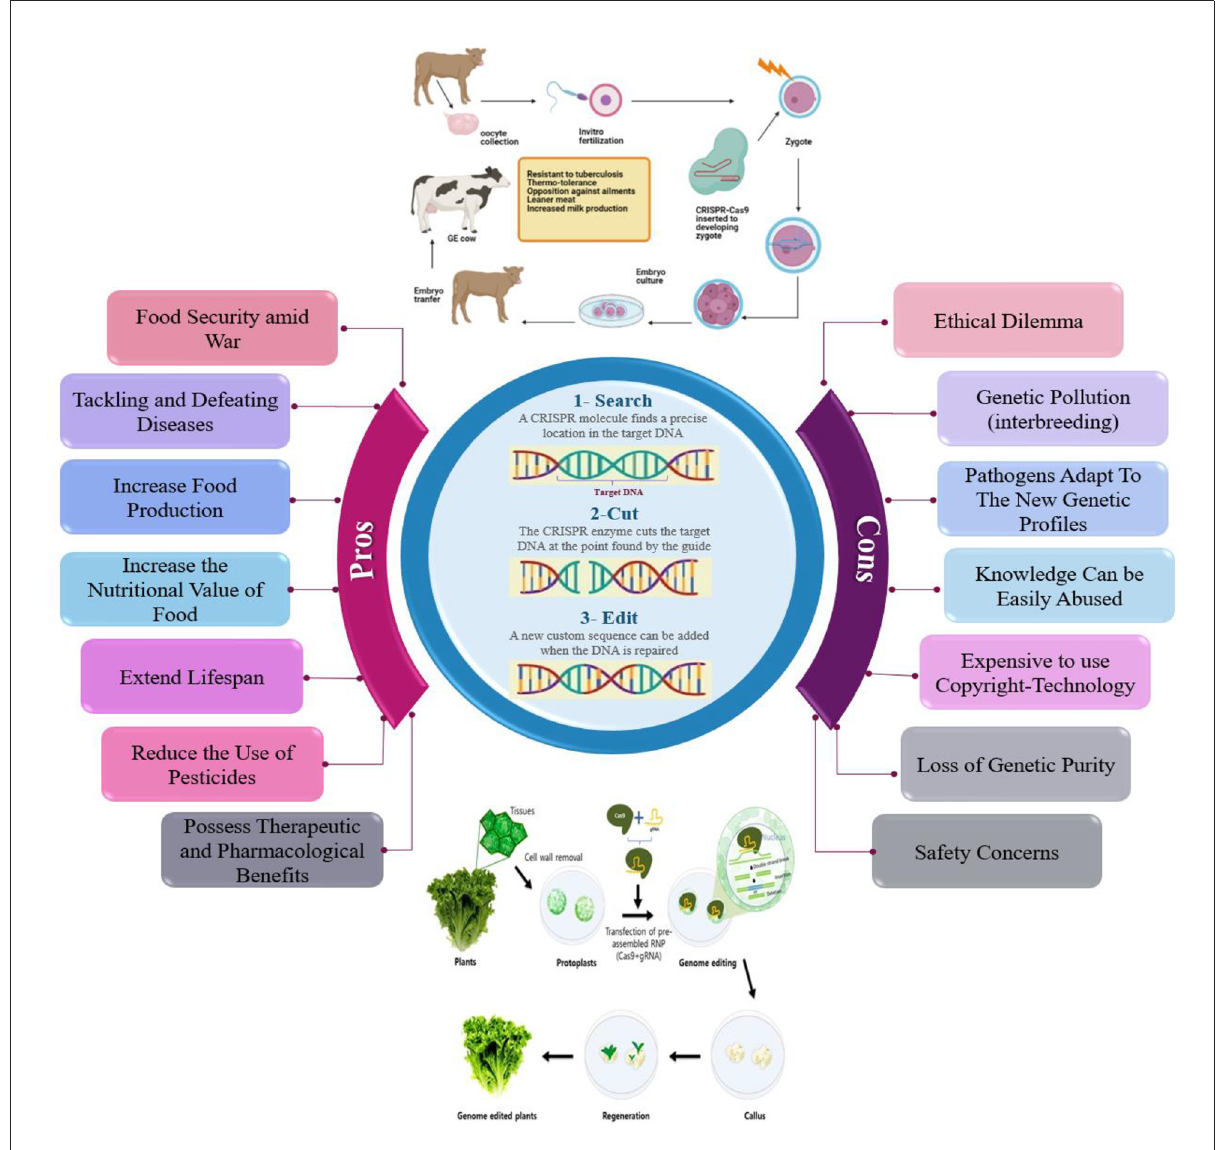
FIGURE4 Process for the gene-editing with its pros and